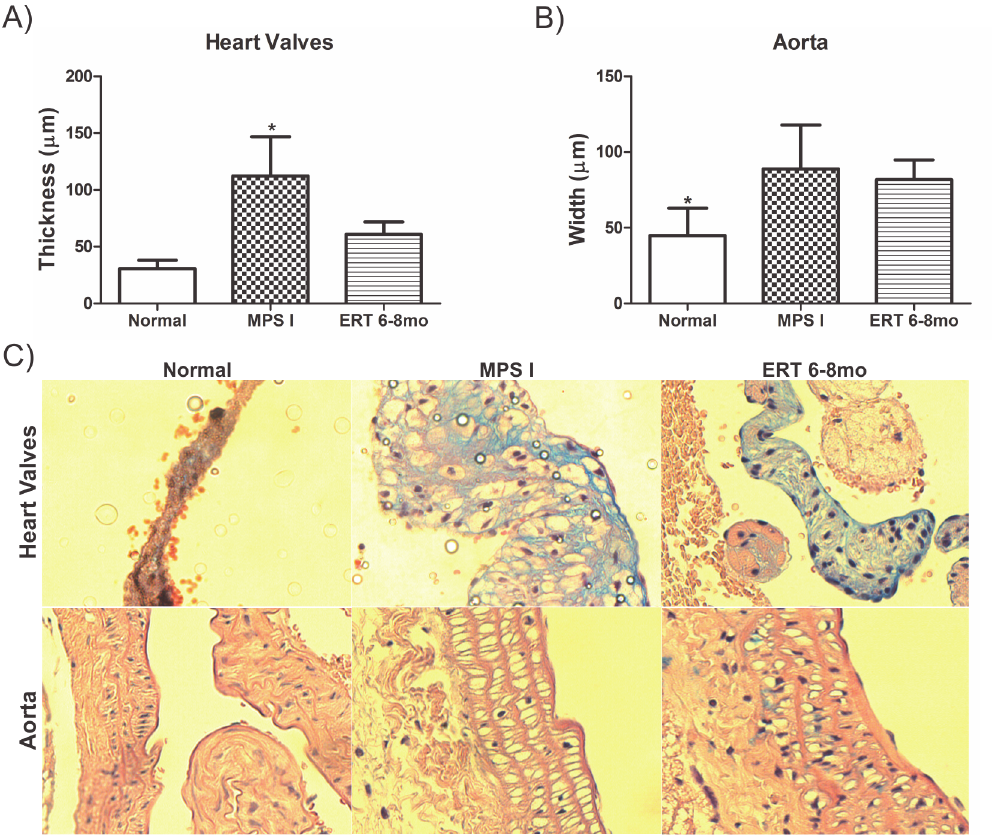
Fig 3. Heart valves and Aorta. A) Heart valve thickness and B) Aortic wall width in 8-month old normal (n = 3/4), MPS I (n = 3/5) and 6 to 8 months laronidase treated MPS I (ERT 6 – 8mo, n = 5/10), 2 weeks after last injection. * P (cid:1) 0.03, ANOVA and Tukey post hoc . C) Heart valves and aortas stained with H-E and Alcian Blue. The presence of large vacuoles and intense alcian blue staining indicating GAG storage are evident in thick MPS I mice valves but are significantly reduced in treated animals. A large amount of vacuoles are also seen in the dilated MPS I and ERT 6 – 8mo aortas. Original magnification,